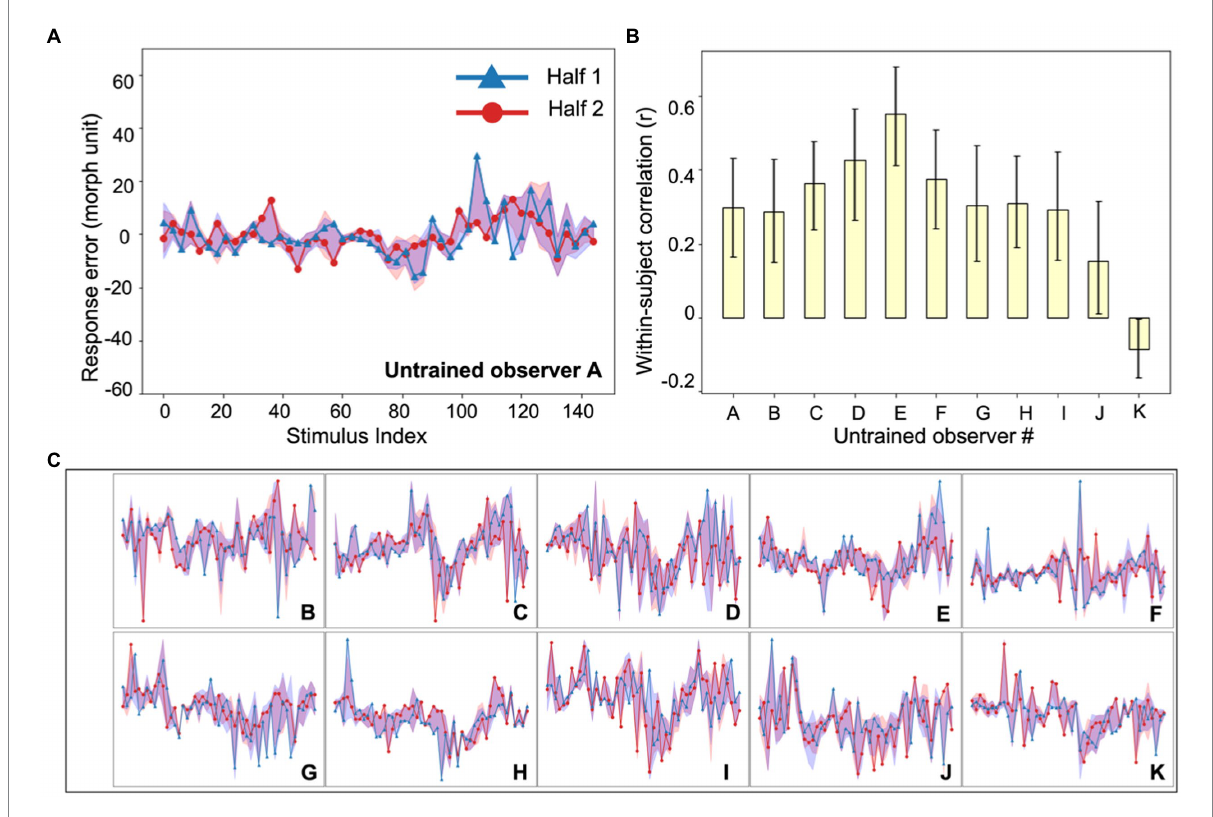
FIGURE 3 Experiment 1, individual differences in untrained observer perception of simulated tumors. (A) An example untrained observer’s error plot (as in Figure 2). The shaded ribbons around the two halves (red and blue data) represent the 95% bootstrapped confidence intervals for each half. (B) The bootstrapped within-subject correlation for each untrained observer (c.f., the group average in Figure 2C). One observer (Observer K) showed a moderately negative within-subject correlation, but this could be due to chance. Error bars represent the 95% bootstrapped CIs. (C) Individual subject error plots for untrained observers B-K. The individual differences previously found among radiologists (Figure 2) were replicated with the untrained observers. Ordinate and abscissa for each error plot in (C) are identical to those in panel (A)